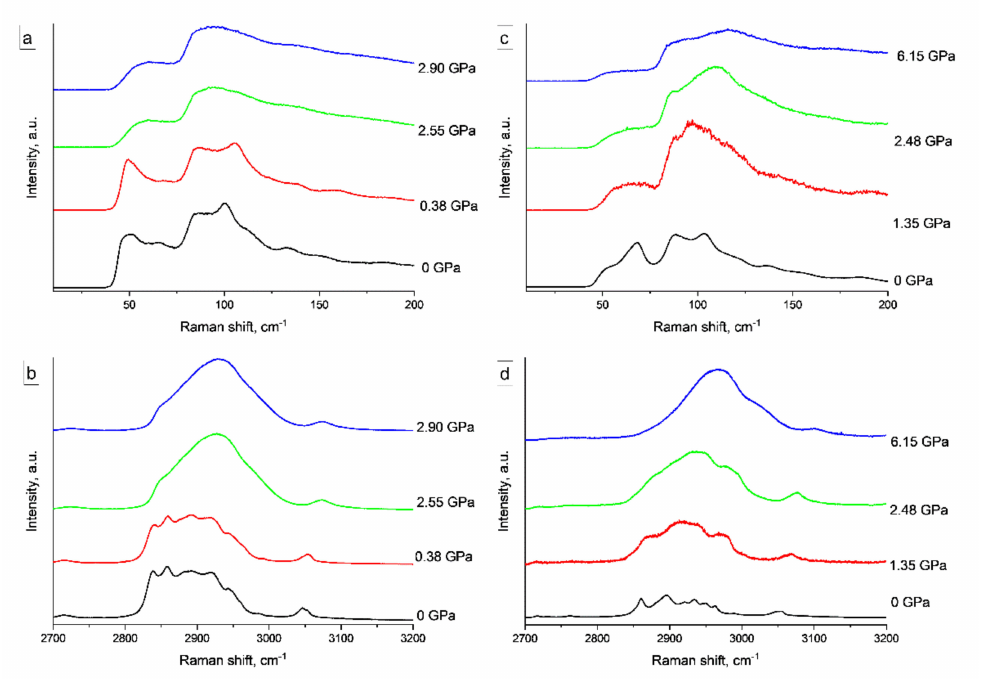
Figure 5. Raman spectra of LLHM at multiple pressures at ( a , c ) low-frequency and ( b , d ) high- frequency regions, showing different behavior in paraffin ( left ) and PIP ( right )